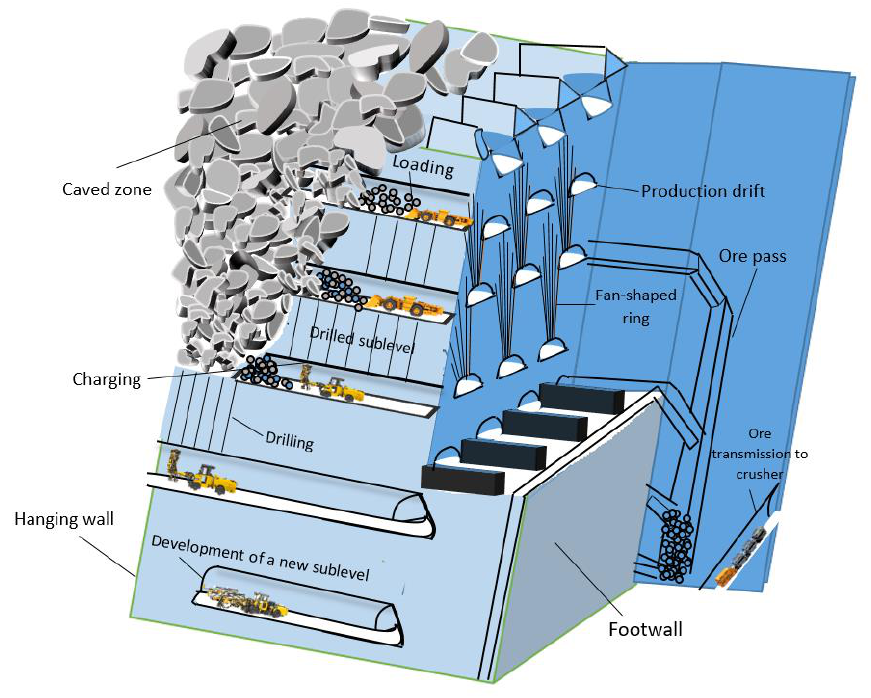
Figure 1. Schematic layout of SLC (Shekhar, 2020) [8] .